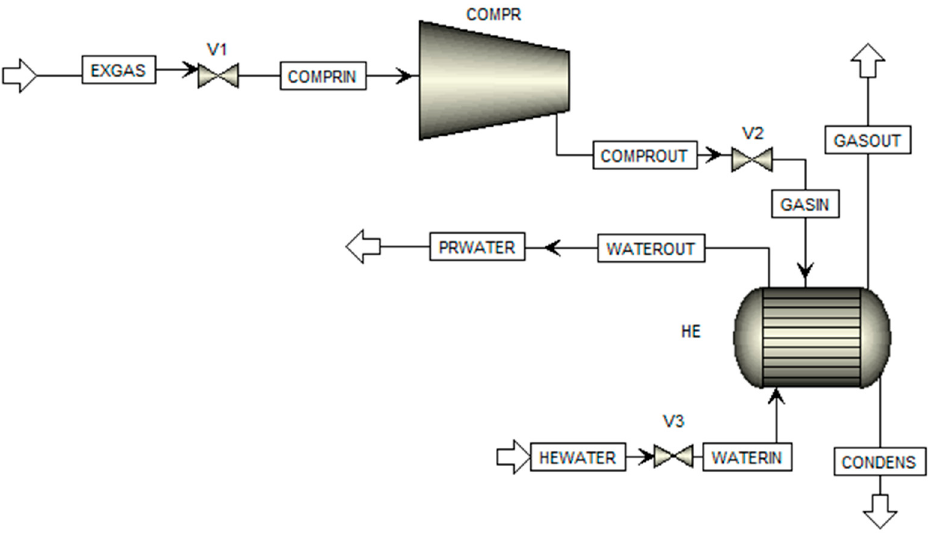
Figure 3. Flowsheet for the concept with the compression of the flue gas.